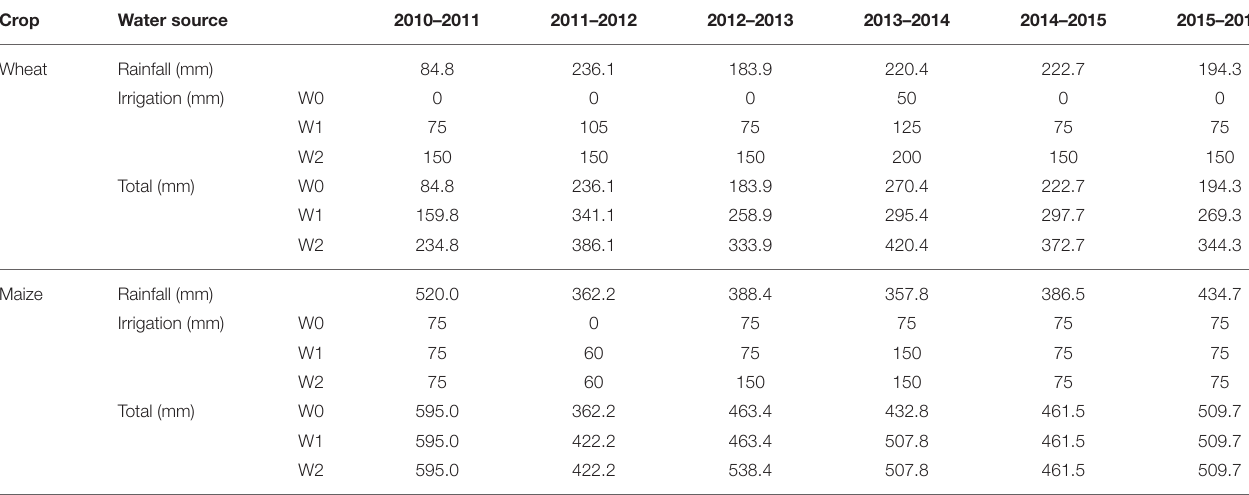
TABLE 1 | Water supply for the 2010–2011 to 2015–2016 winter wheat and summer maize growing seasons.